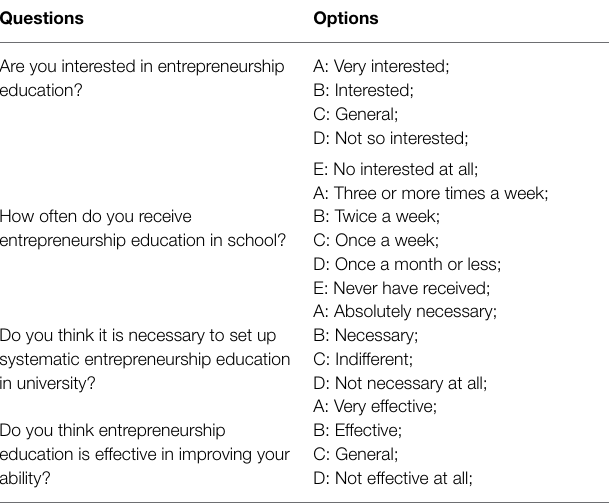
TABLE 1 | The distribution of key items in the QS of college students’ entrepreneurship education and the questions